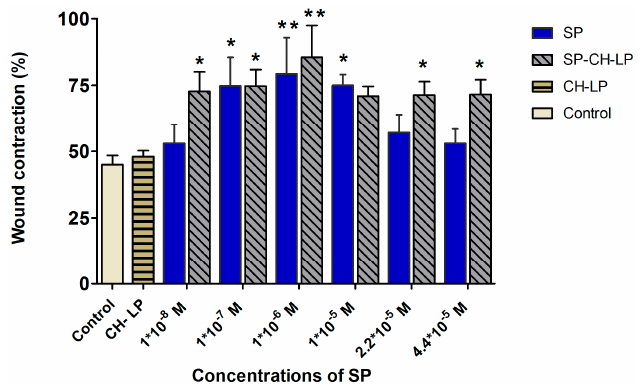
Figure 5. Effect of treatment with varying concentrations of free and liposome-encapsulated substance P on relative wound healing in HaCaT cells, as measured by Ibidi ® silicone insert in vitro wound healing assay over 23 h (data represent the mean average ± standard deviation, n = 3 to 6; cell culture media (DMEM) with supplements were used as control; stars on bars represent significant differences with respect to control by ANOVA followed by the Tukey multiple comparison test. * p < 0.05, ** p < 0.001). Close inspection reveals that at 23 h, the cells treated with 1 × 10 − 6 M free SP closed their gap by 82 ± 4.6%, a value significantly ( p ≤ 0.01) greater than that registered for the untreated